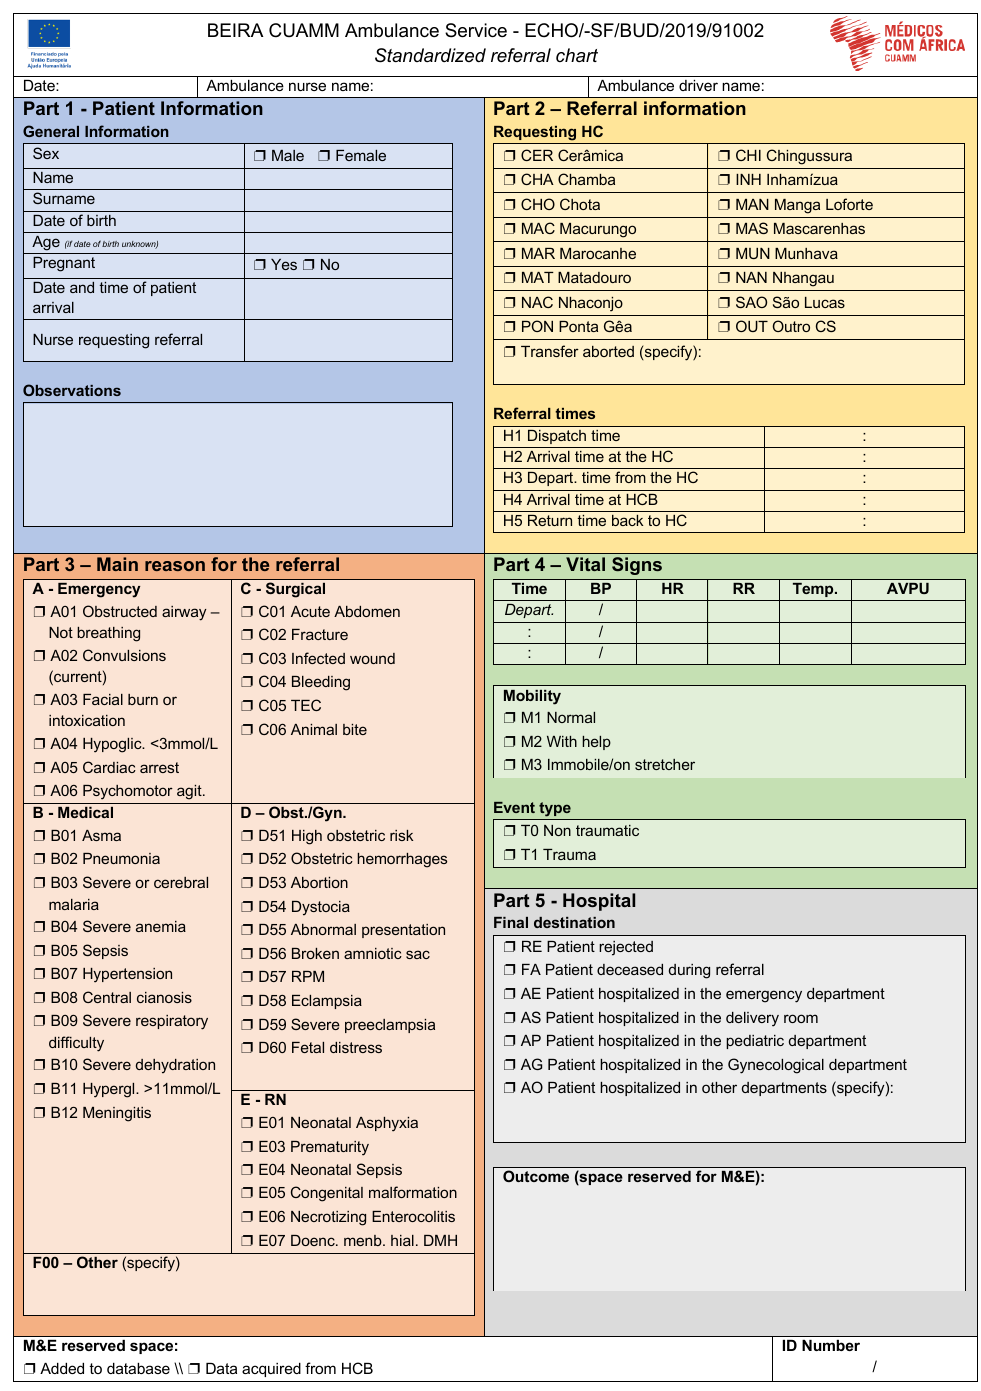
Figure A2. Patient’s referral chart (English translation: the original chart was developed and imple- mented in